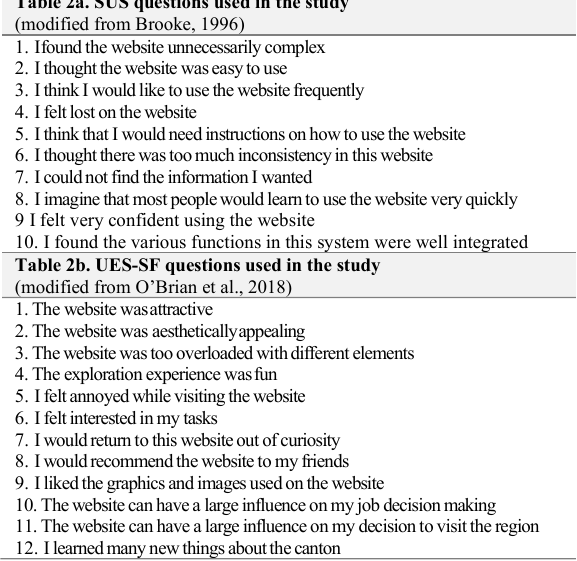
Table 2a. SUS questions used in the study (modified from Brooke, 1996)